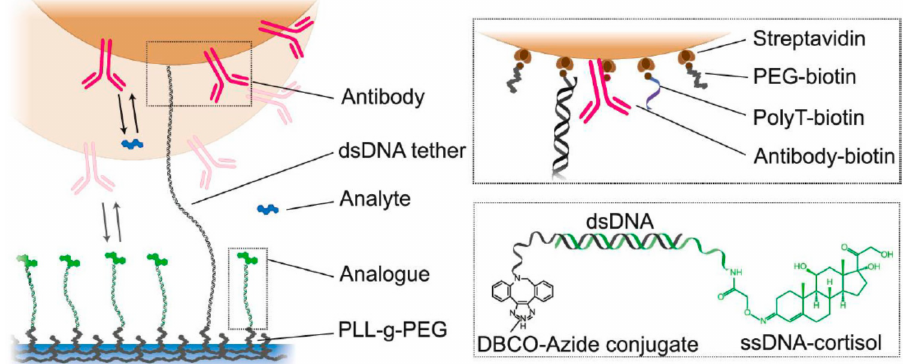
Figure 7. Competitive equilibrium binding of the free cortisol and cortisol hapten bound with a DNA linker to the polymer on the surface. Here, the cortisol concentration influences the mobility of the microparticles bound to the surface—when cortisol is abscent, microparticles are bound tight to the surface, and free cortisol displaces the surface-bound by the short DNA linker cortisol hapten, which could be detected by the analysis of the mobility of the microparticles by optical methods [43]. Reprinted with permission of ACS